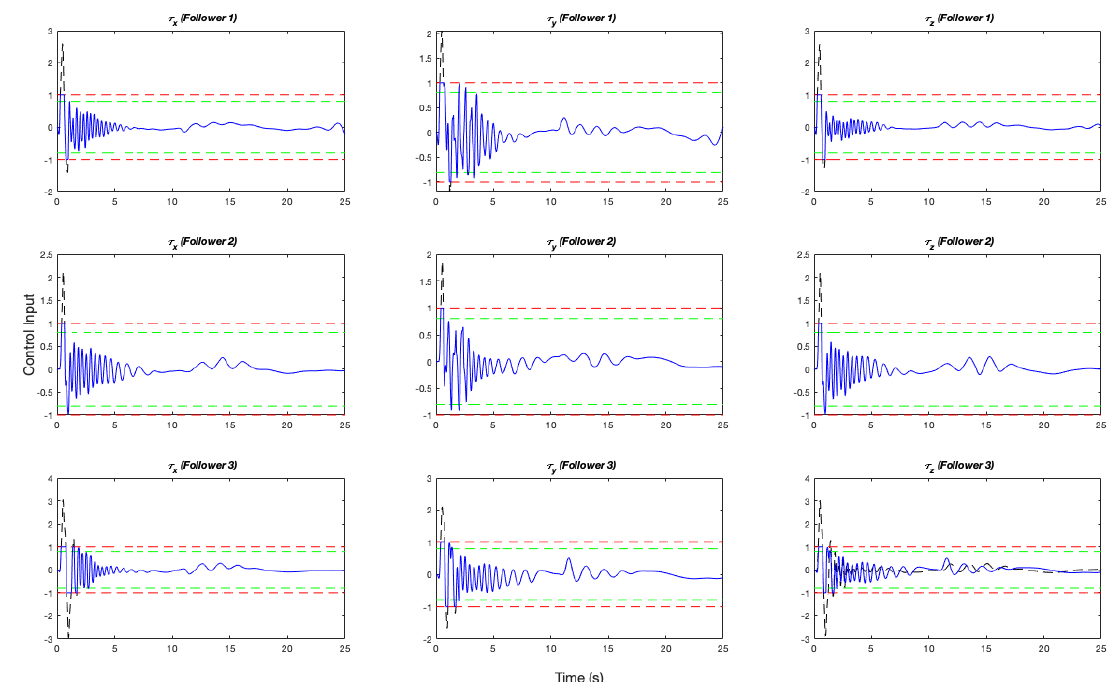
Figure 6. Control input of the followers (blue is the actual control input and black is the commanded control input) ( µ =